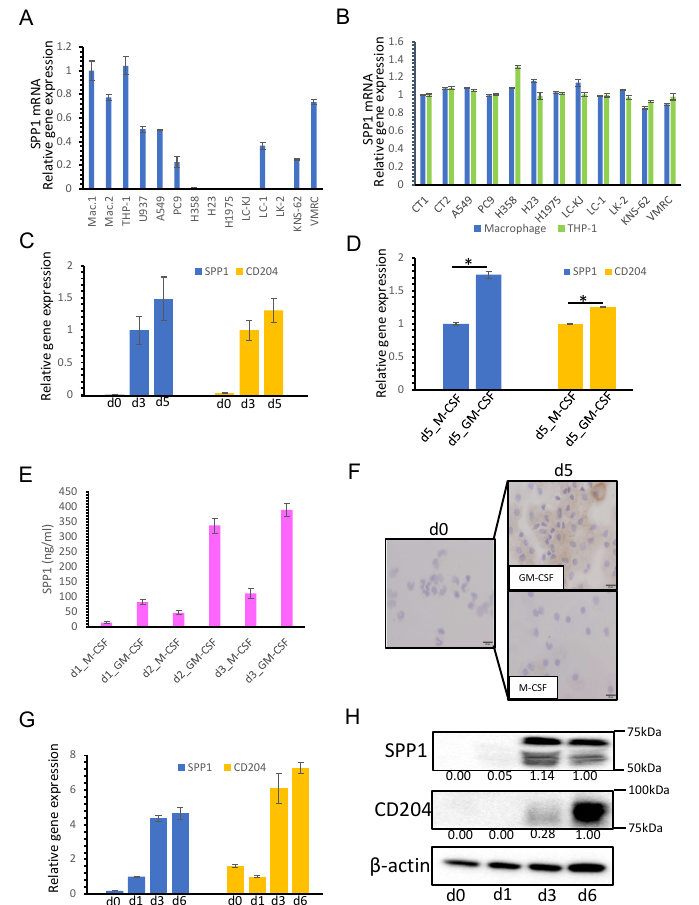
Figure 4. SPP1 expression in macrophages. ( A ) SPP1 expression in macrophages, THP-1 cells, U937 cells, and 10 lung cancer cell lines was examined by qRT-PCR. ( B ) Macrophages (blue) and THP-1 cells (green) were stimulated with the CM of cancer cell lines; then, the SPP1 mRNA expression level was evaluated. Control (CT) refers to macrophages or THP-1 without CM of cancer cell lines added. ( C ) Monocytes were cultured with M-CSF and GM-CSF as described in the Materials and Methods section, and SPP1 mRNA and CD204 mRNA levels were evaluated at different stages of monocyte/macrophage culture (days 0, 3, and 5). ( D ) Monocytes were cultured with M-CSF or GM-CSF for 5 days, and SPP1 and CD204 expression levels were examined. ( E ) SPP1 (cid:48) s concentration (ng/mL) in the CM of macrophages cultured with M-CSF or GM-CSF was examined by ELISA at days 1 to 3 (n = 3). ( F ) Immunocytostaining of SPP1 in the macrophages cultured with M-CSF or GM-CSF at days 0 and 5. ( G ) SPP1 and CD204 expression levels in THP-1 cells differentiated for 0, 1, 3, or 6 days were examined by qRT-PCR ( G ) and Western blot analysis ( H ). *: statistically significant, p value <